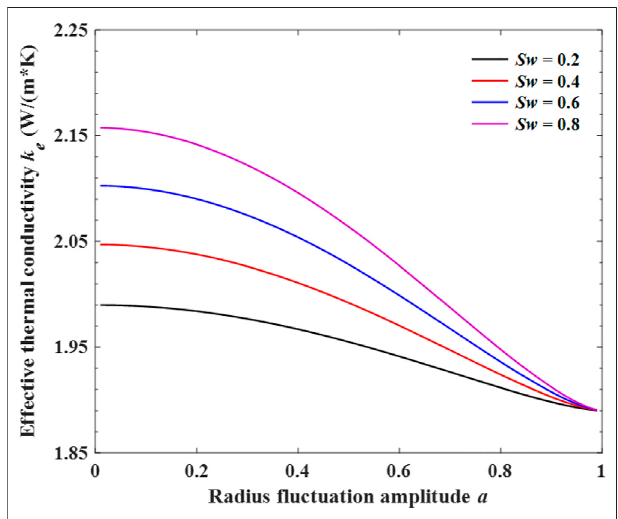
FIGURE 8 | The effect of tortuosity fractal dimension on the ETC.